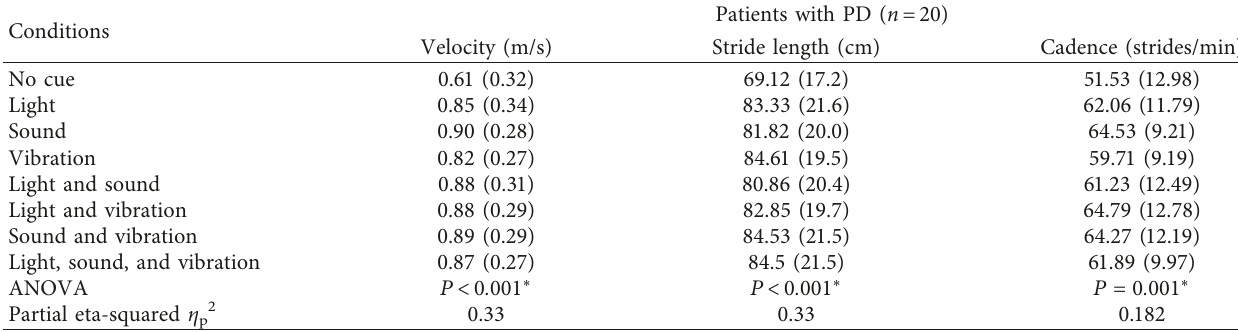
Table 1: The outcome measures in 8